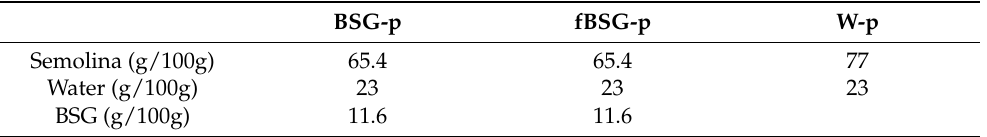
Table 1. Formulas for pasta containing fermented and native brewers’ spent grain (BSG): BSG-p, pasta containing native brewers’ spent grain (15% wt/wt in replacement of semolina); fBSG-p, pasta containing fermented brewers’ spent grain * (15% wt/wt in replacement of semolina); W-p, pasta made with durum wheat semolina. BSG-p fBSG-p W-p Semolina (g/100g) 65.4 Water (g/100g) 23 23 23 BSG (g/100g) 11.6 11.6 * BSG homogenized with water at a 60:40 ratio was added by Depol (100 nkat/g dough) and incubated at 50 ◦ C for 5 h. After enzymatic treatment, Lactiplantibacillus plantarum PU1, cultivated as above described, was inoculated (initial cell density ca. 7.5 cfu/g) and incubated at 30 ◦ C for 24